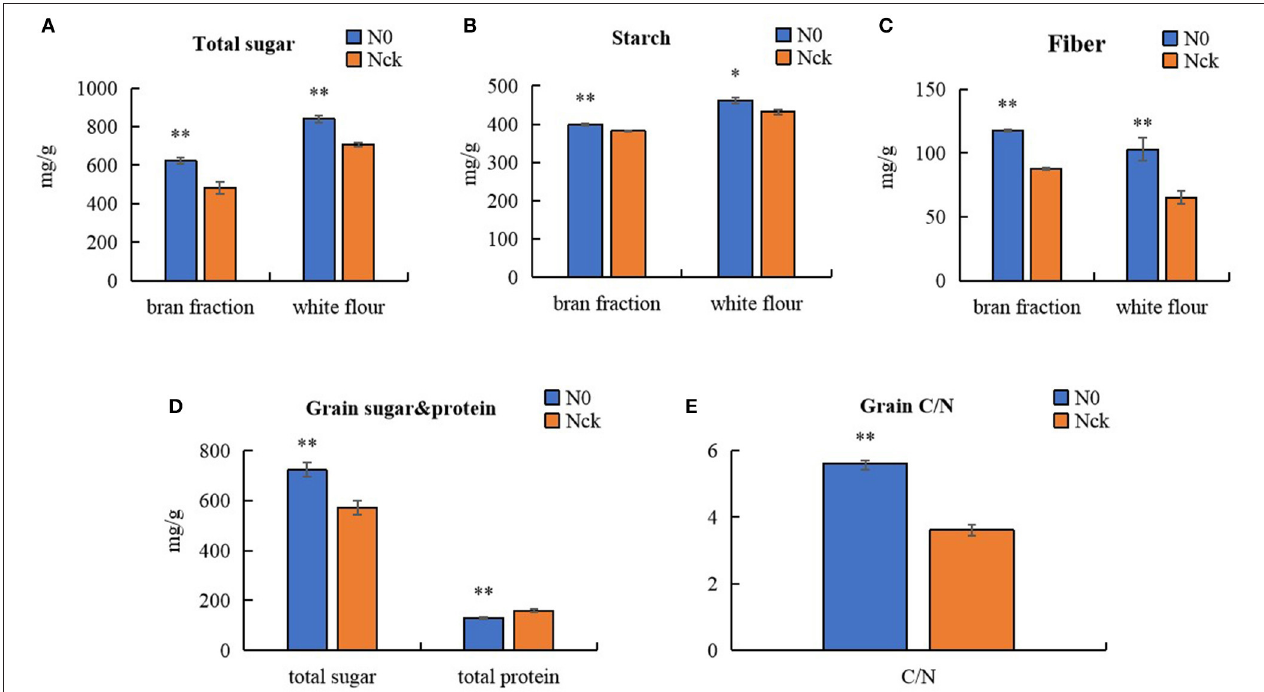
FIGURE 2 | Content of total sugar, starch, and fiber in the bran fraction and white flour. (A) Total sugar in the bran fraction and white flour. (B) Starch in bran fraction and white flour. (C) Fiber content in the bran fraction and white flour. (D) Total sugar and total protein contents in matured grain. (E) Ratio of carbohydrate to protein, known as C/N. The blue columns represent the N0 treatment, orange columns represent the Nck treatment. * P < 0.05 significant difference, ** P < 0.01 extremely significant